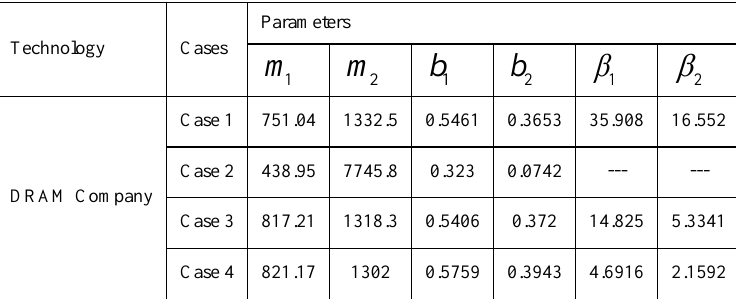
Table 2. Parameter estimation